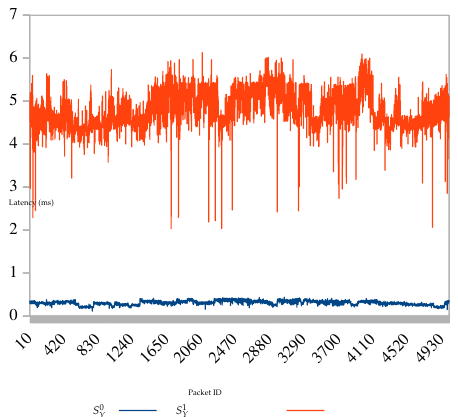
Figure 5. Samples used for cost modeling ( (cid:98) θ Y ).